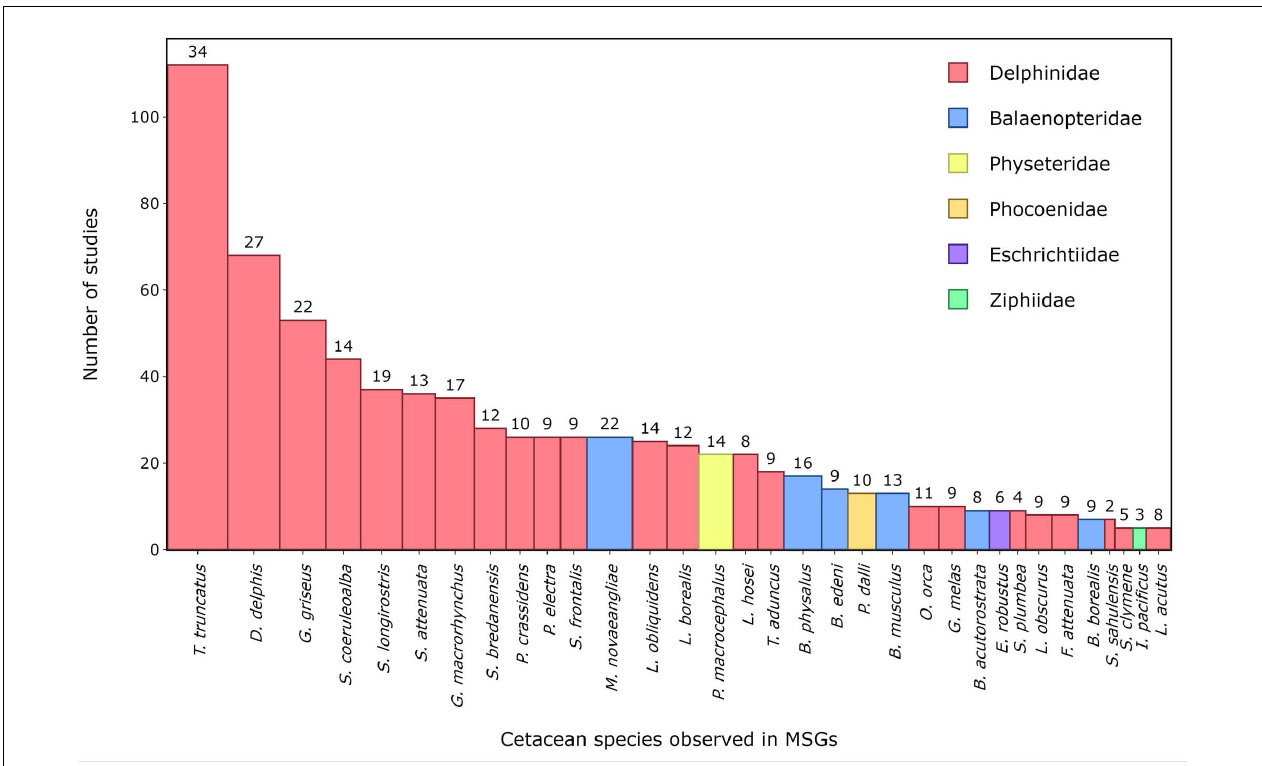
FIGURE 3 | The 33 species of cetaceans that were reported in mixed-species groups (MSGs) by five or more studies published between 1961 and 2020 that were obtained from a literature review on cetacean MSGs. The bar heights represent the number of studies reporting each species’ participation in MSGs as displayed on the y axis. The bar widths are proportional to the total number of species that each species has been observed with in MSGs, i.e., the number of partner species, which is written above each bar. The bars are coloured according to the species’